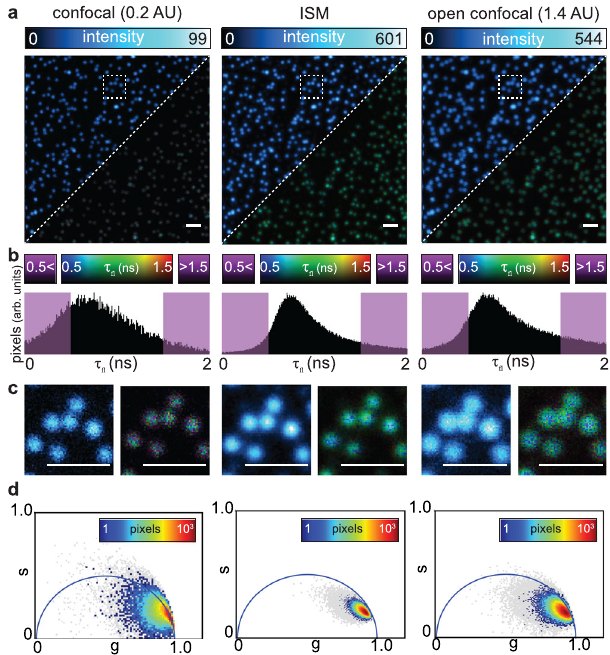
Fig. 3 | BrightEyes-TTM for FLISM. Imaging and FLISM analysis of 100nm fl uor- escent beads with a custom-built single-photon laser-scanning microscope equip- ped with a 5×5 SPAD array detector prototype. a Side-by-side comparison of confocal(left,pinhole0.2AU),adaptivepixel-reassignmentISM(center),andopen confocal (right, pinhole 1.4 AU). AU=Airy unit. Each imaging modality shows both the intensity-based image (top-left corner) and the lifetime image (bottom-right corner). A bidimensional look-up-table represents in the lifetime images both the intensity values (i.e., photon counts) and the excited-state lifetime values (i.e., τ fl ). The intensity-based images integrate the relative 3D data ( x , y , Δ t ) along the start – stop time dimension Δ t . b Histogram distributions showing the number of pixels versus lifetime values — in violet lifetime values which fall out of the selected lifetime interval.The selected interval waschosen by visually inspecting the FLISM image. The same intervals were used for the confocal and open confocal data. The lifetime images report in violet the pixels whose lifetime is in this interval. c Zoomed regions in the white-dashed boxes, with the intensity panels re- normalizedtothemaximumandminimumvalues. d Pixelintensityphasorplots,5% and 10% thresholds respectively in gray and color. Pixel dwell time 100 μ s. Scale bars 2 μ